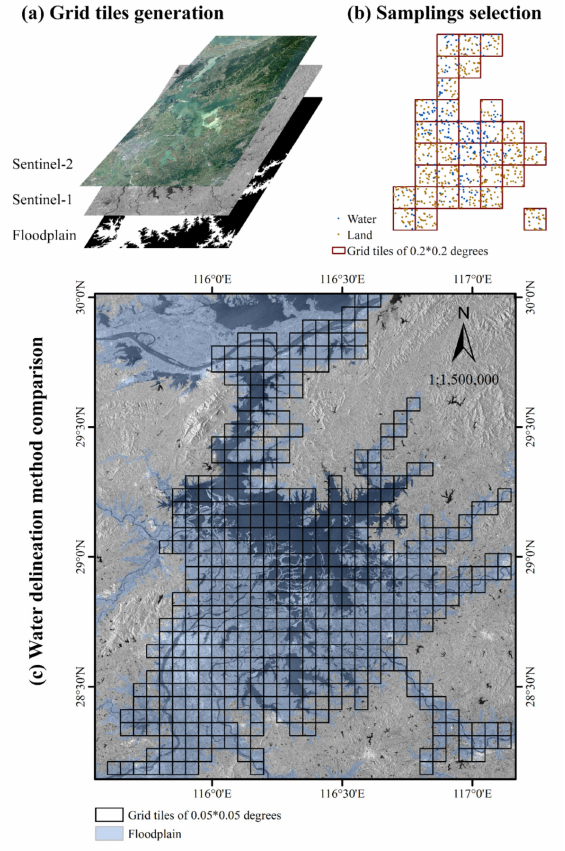
Figure 4. The procedure of water delineation methods comparison. ( a ) Grid tiles generation by overlapping floodplain dataset, Sentinel-1 and Sentinel-2 imagery with close dates; ( b ) Water/land samplings creation through visual interpretation within the grids of 0.2 × 0.2 degrees; ( c ) grid tiles of 0.05 × 0.05 degrees overlaying the Sentinel-1 imagery for water fraction calculation and methods